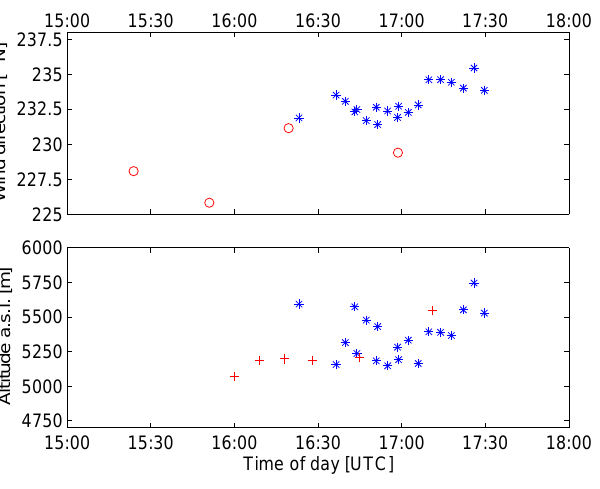
Fig. 10. The figure shows the results of model run A2. The AEC was set to 10km − 1 corresponding to a visibilityof400minsidetheplume,whichismarkedasshadedarea. Thegraphdepictssimulated SO 2 column density asafunction of thedistanceof theinstrument from theplume.